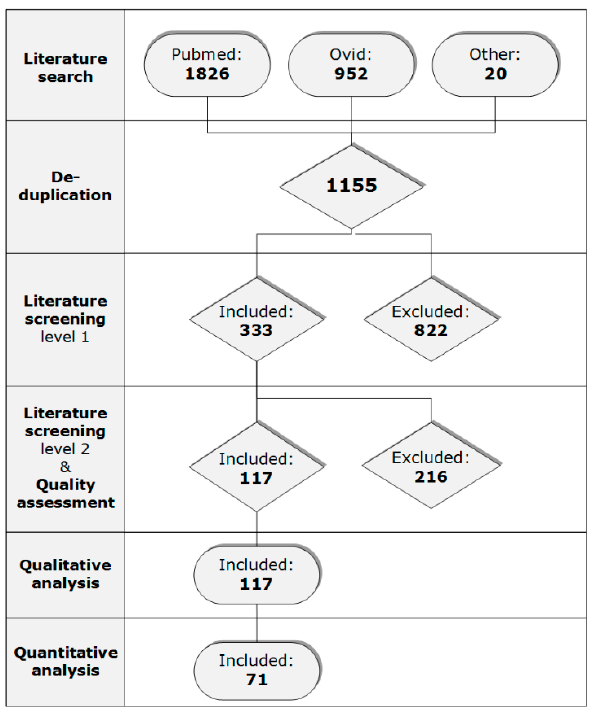
Figure 1. The number of the included and excluded citations during the literature search, both literature screening levels, quality assessment and both analyses.